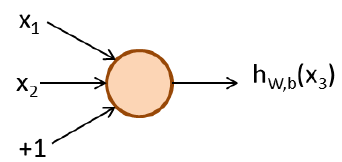
Figure 1. A diagram denoting a neural network with a single neuron.